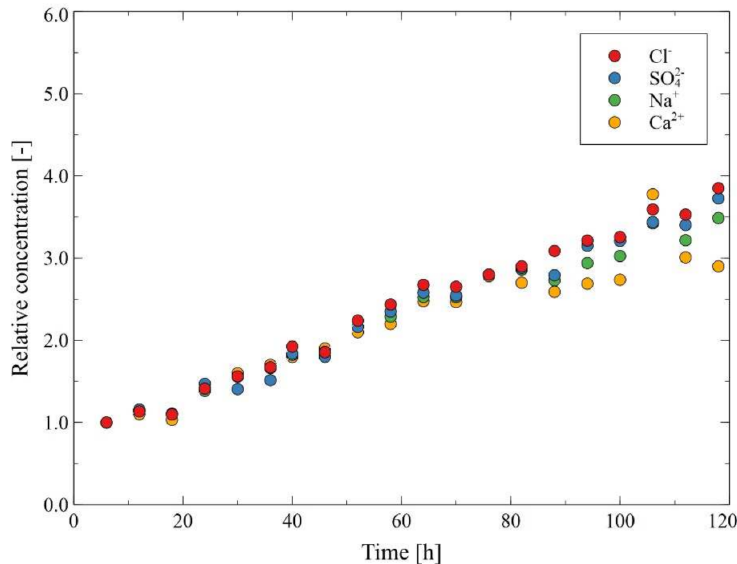
Figure 11. Changes in the composition of the feed during desalination of the Baltic Seawater. T F = 343 K, v F = 0.12 m/s. Module